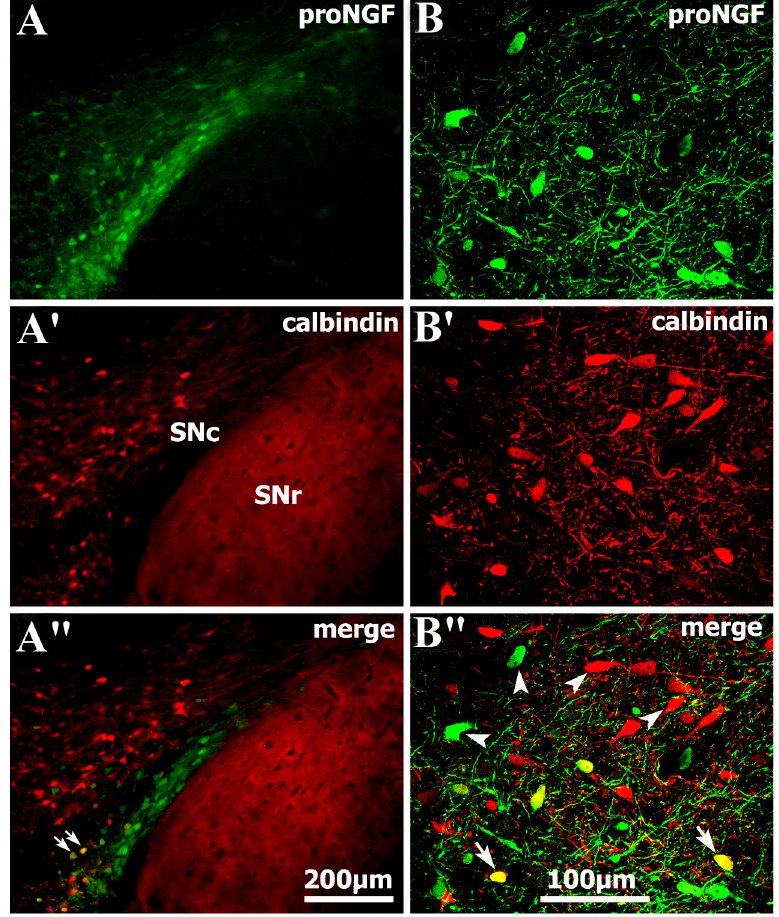
Figure 3. Double immunofluorescence showing colocalization of proNGF and calbindin-D28K in the nigral neurons. ( A-A ꞌꞌ ) Only are a few of proNGF/calbindin-D28K double-labeled neurons detected in the ventral tier group of substantia nigra, and double-labeled ones are indicated with arrows; and ( B-B ꞌꞌ ) while more single-labeled ones are representatively indicated with arrowheads, which are shown with higher magnification in the right